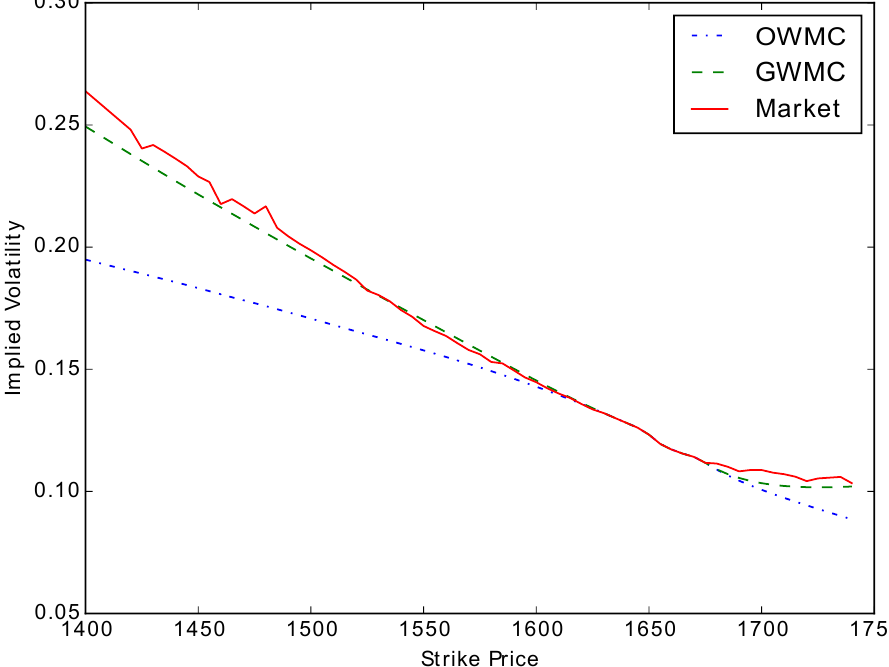
Figure 5. The volatility for SPX options with maturity 30 days implied by market prices, the OWMC calibrated Heston model, and the GWMC calibrated Heston